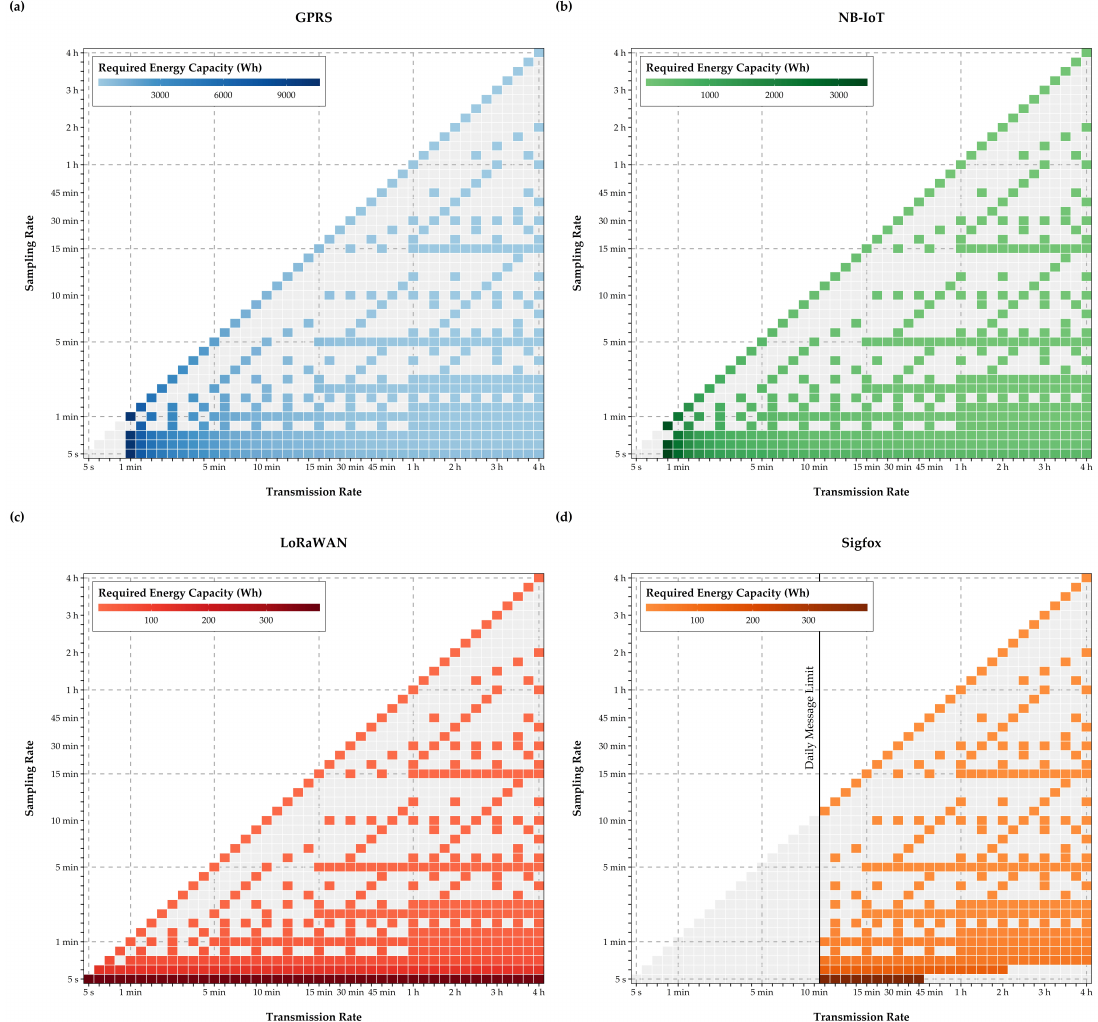
Figure 10. Expected battery capacity for five years of maintenance-free EPMD runtime ( a – d